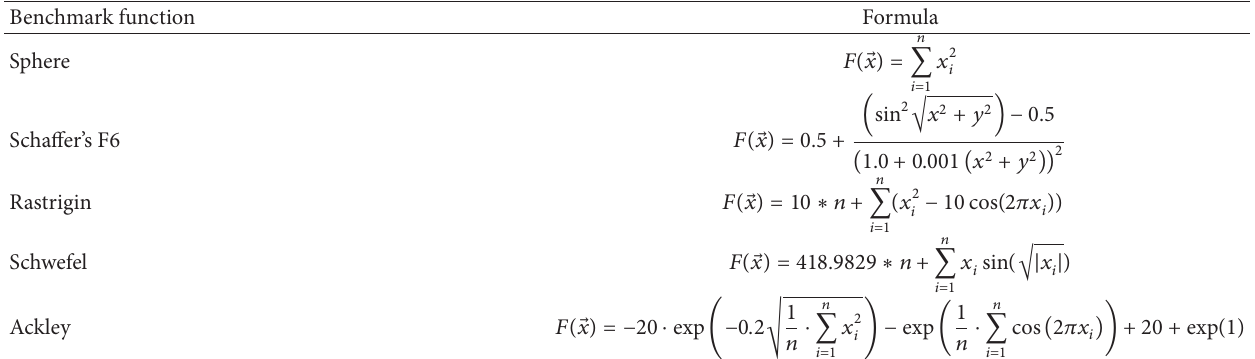
Table 1: Definition of benchmark functions.